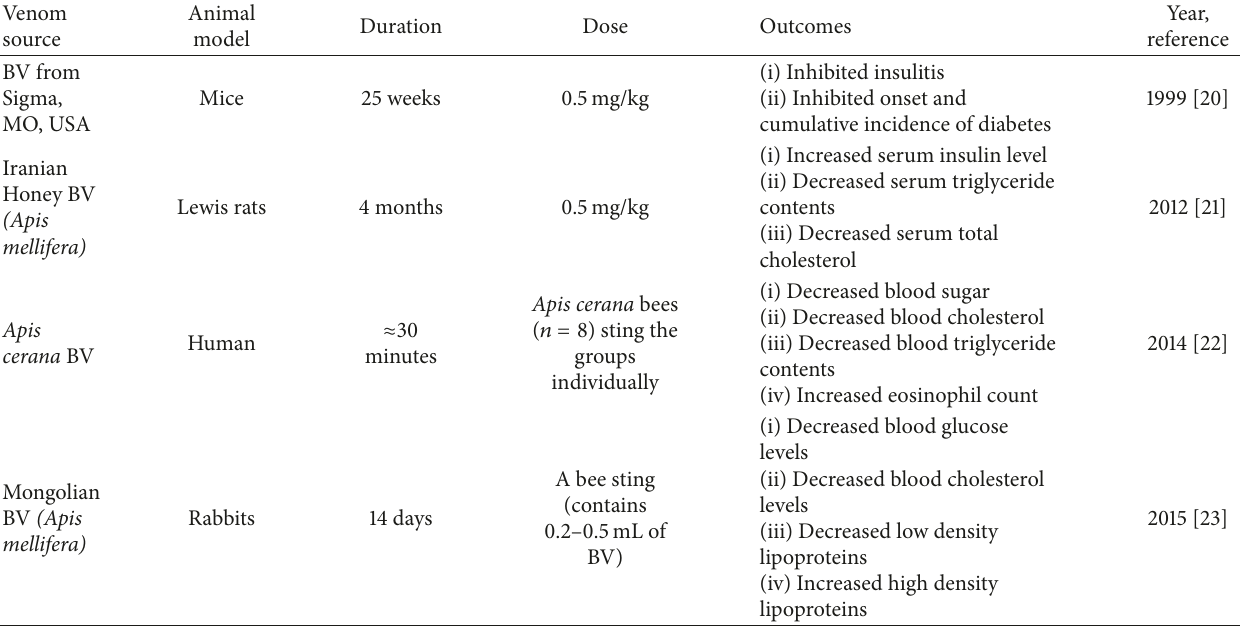
Table 2: In vivo studies of DM based on